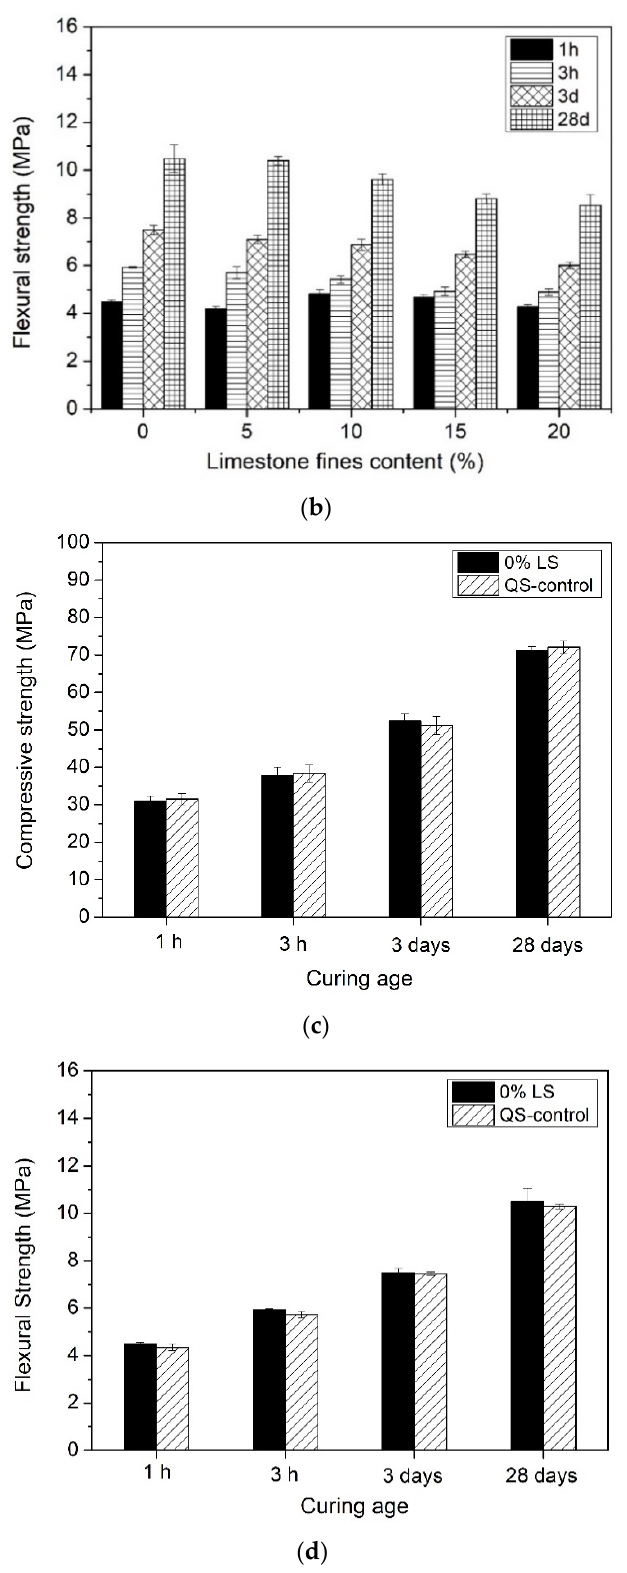
Figure 6. ( a ) Compressive strength and ( b ) flexural strength of MPAC mortar with limestone